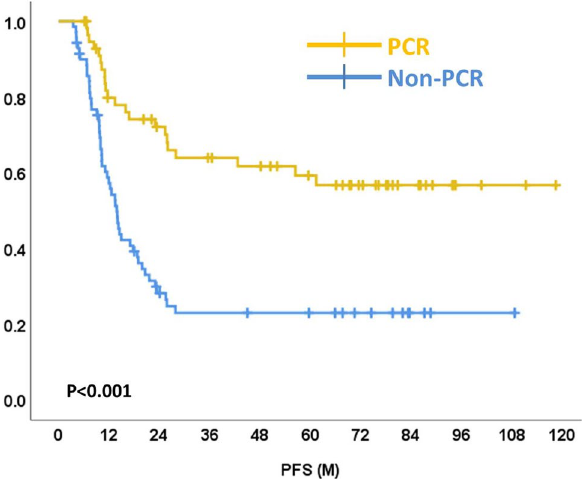
Figure 3. Progression-free survival curves of esophageal cancer patients with pCR and